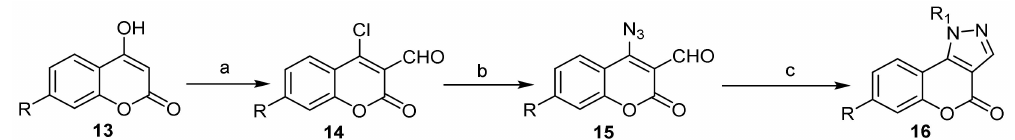
Scheme 5. Synthesis of chromeno[4,3- c ]pyrazol-4(2 H )-ones 16 . Reagents and conditions. ( a ) POCl 3 , DMF, CHCl 3 , 4 outputs with 65–80% yield; ( b ) NaN 3 , DMF, 4 outputs with 50–80% yield; ( c ) R 1 NHNH 2, DMF, 40–50 ◦ C, six outputs with 70–90% yield.